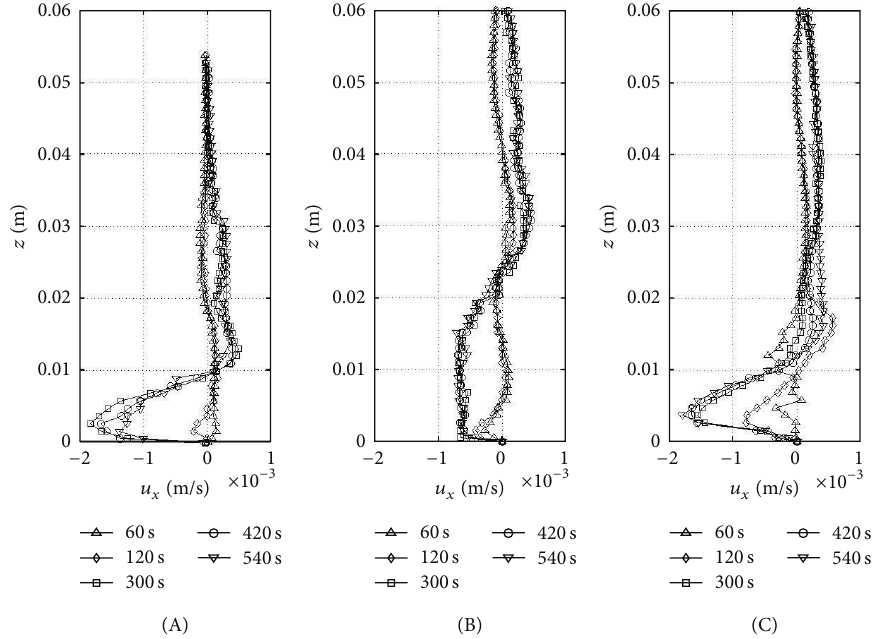
Figure 38: Velocity profiles A, B, and C at 5 time intervals from the beginning of case C3.